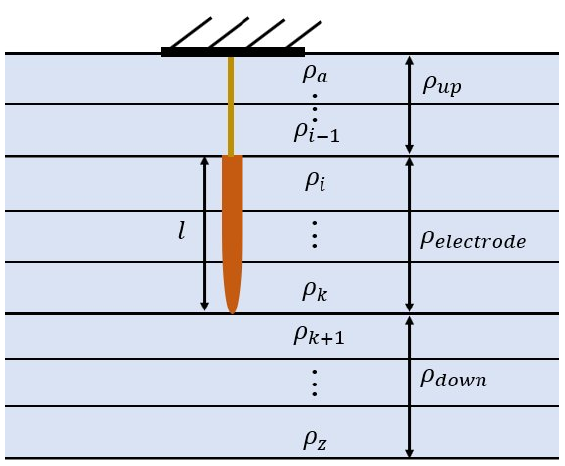
Figure 2. Model of underwater grounding